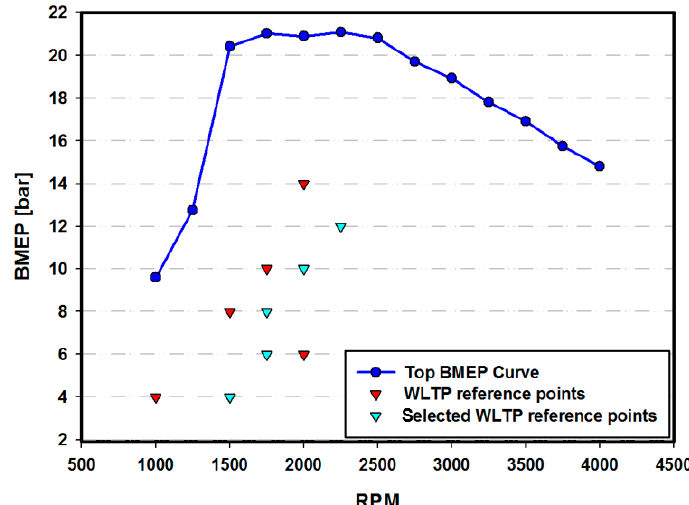
Figure 1. Worldwide harmonized light-duty vehicles test procedure (WLTP) reference points and selected reference points.